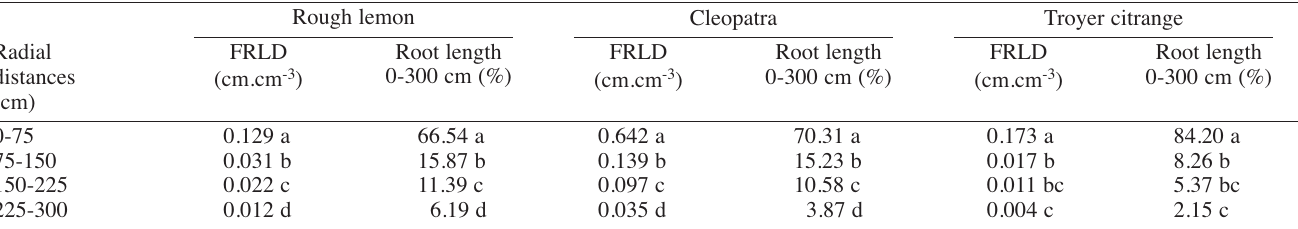
Table 2 - Pineapple orange tree mean fibrous root length density (FRLD) and percentage of root length in the upper 60 cm of soil for rootstock and distance from the tree trunk Radial